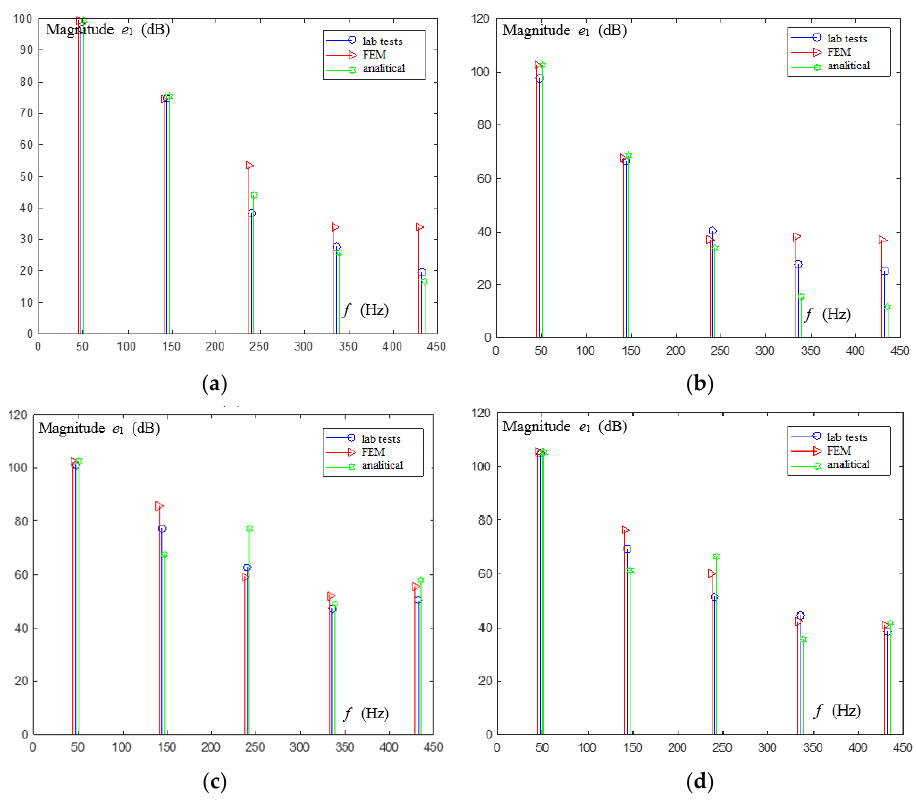
Figure 24. FFT spectrum of EMF for laboratory measurements, finite element analyses and analytical calculations: ( a ) generator G1; ( b ) generator G2; ( c ) generator G3; ( d ) generator G4. Table 2. Comparison of the results obtained from analytical models and laboratory tests for THD factors of EMF.